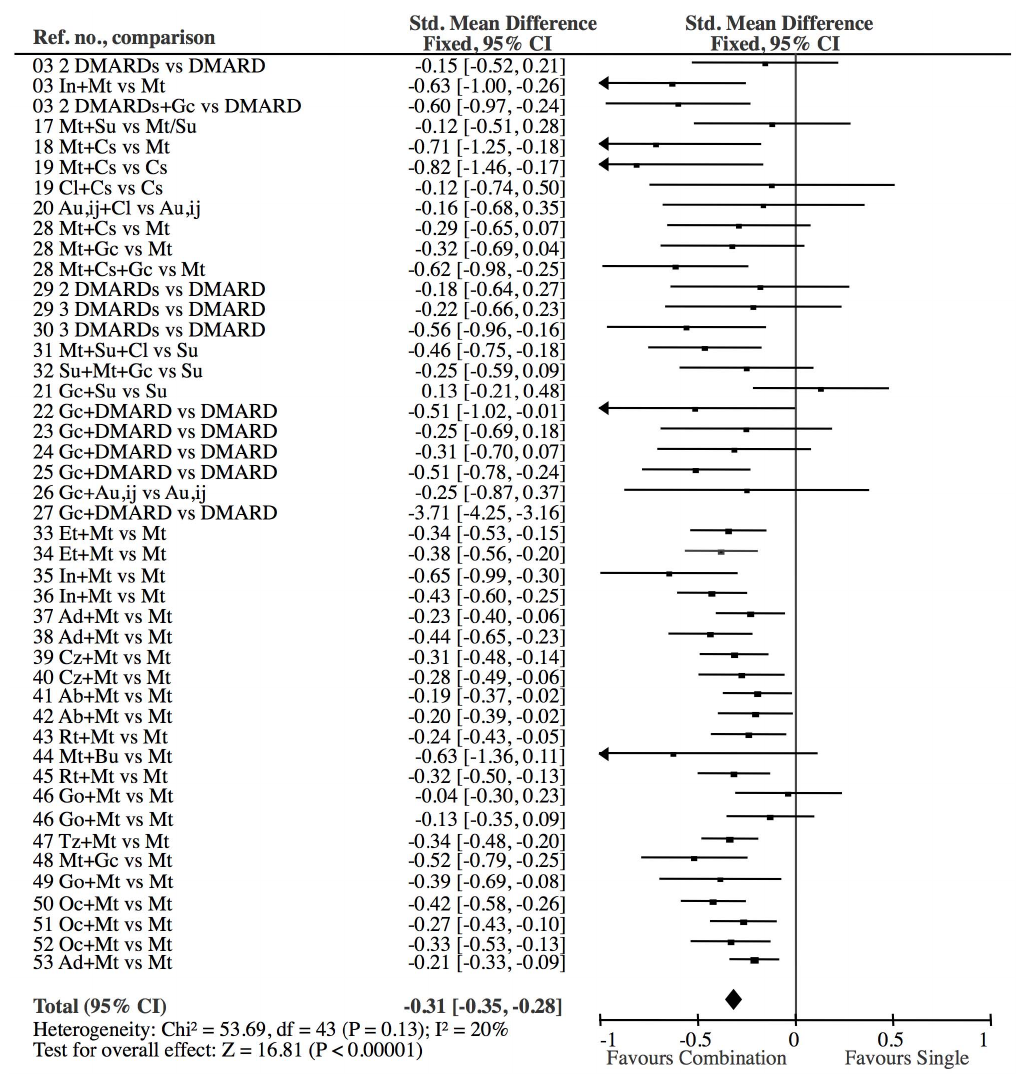
Figure 2. Combination treatment versus single DMARD. The effect on all studies is 2 0.33 SMD (CI: 2 0.36, 2 0.29). Test for overall effect: Z=17.66 (P , 0.00001). Heterogeneity: Chi 2 =201.54, df=44 (P , 0.00001); I 2 =78%. One study [27] contributed to heterogeneity due an extreme effect ( 2 3.71 SMD). The elimination of this study resulted in a little more conservative estimate ( 2 0.31 SMD (CI: 2 0.35, 2 0.28), Z=16.81), but eliminated the significant heterogeneity (I 2 =20, p=0.13). Consequently, reference [27] was excluded from all comparisons. N, combination: 6725; N, single: